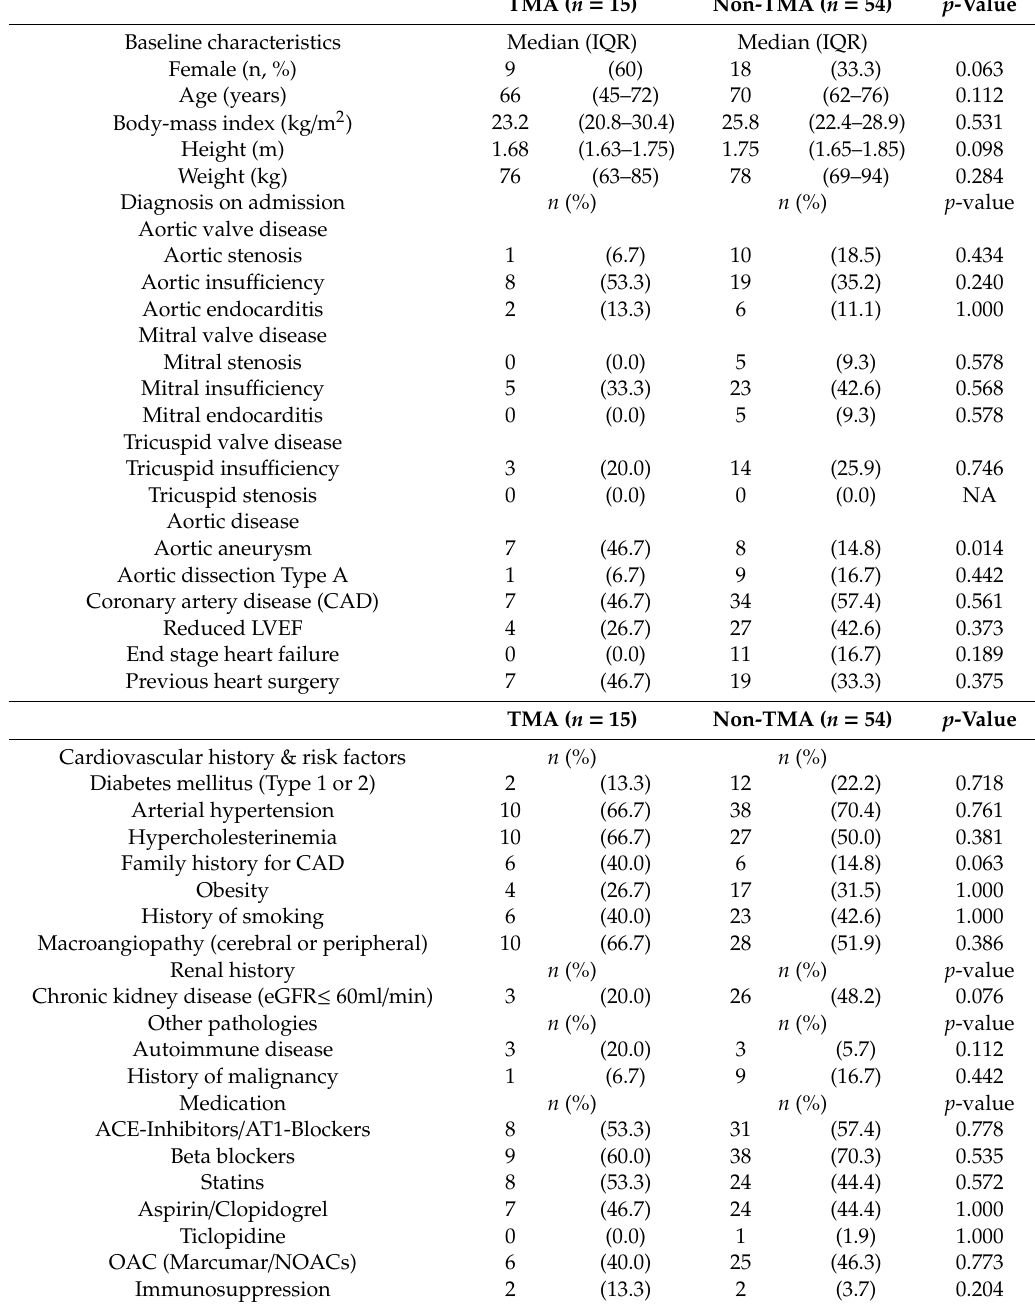
Table 1. Baseline